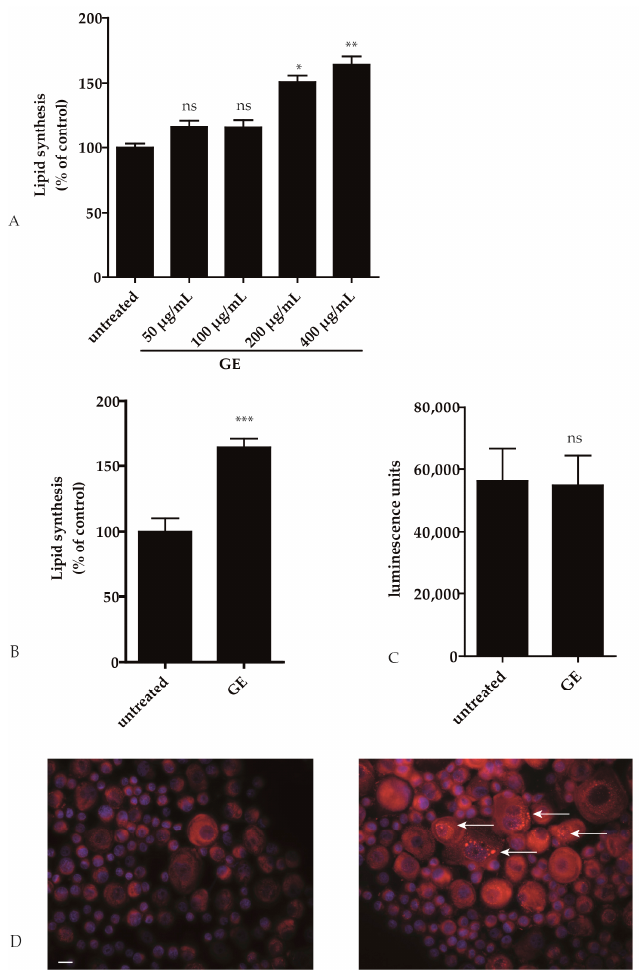
Figure 2. Gentiana lutea extract (GE) enhances lipid synthesis in hPK. ( A – D ) HPKs were treated with 200 µg/mL GE (unless otherwise stated) for 6 days. The graph in ( A , B ) reports the quantitative measurement of intracellular neutral lipids as assessed after Nile Red labeling. Graph C shows cell viability as assessed with the ViaLight Plus bioassay kit; Graph ( D ) shows the qualitative measurement of intracellular neutral lipids after labeled by Nile Red; the nuclei were counterstained with DAPI. The white arrows point to lipid droplets. (ns: not significant, * p < 0.05; ** p < 0.01, *** p < 0.001). The pictures were photographed at a magnification of 400×. The bar indicates 10 µm.